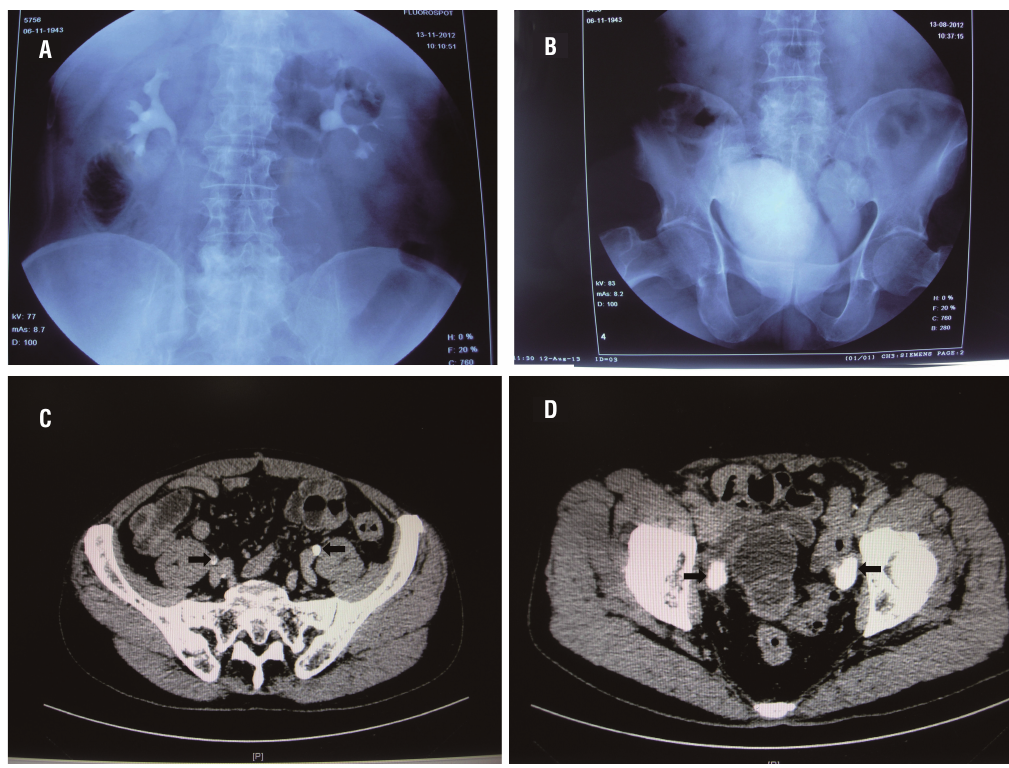
Figure 2 - Image examinations from follow-up. A) An IVP showed the bilateral pelvis and ureters were normal and there were no appearance of hydronephrosis (POD 10 months). B) An IVP showed the shape of the neobladder. C) Delay phase of a enhanced CT scan showed there were no appearance of the dilation of the bilateral ureters (black arrows). D) Delay phase of the enhanced CT scan showed the appearance of the bilateral isoperistaltic afferent limbs (black arrows) and the